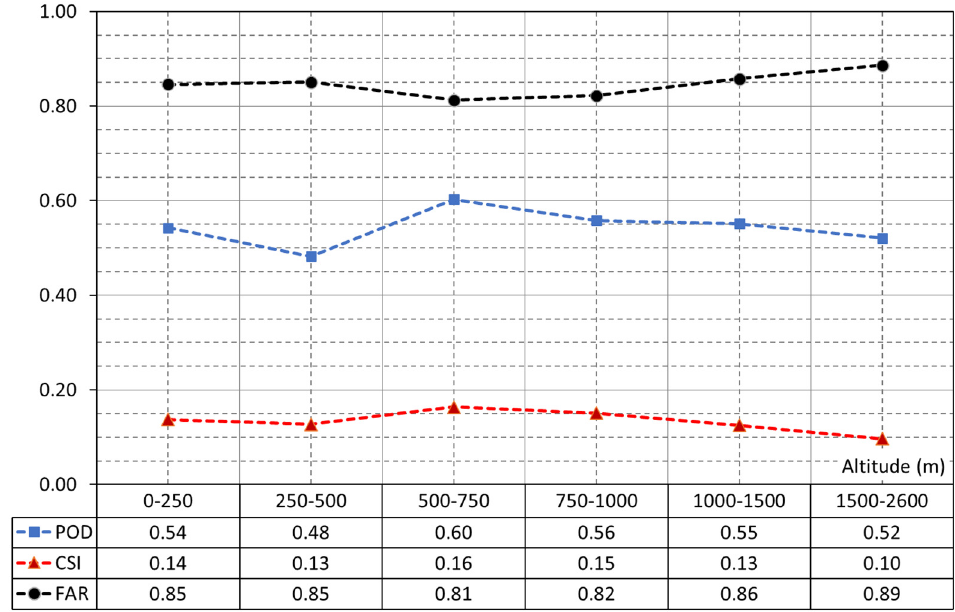
Figure 6. Variation of GPM IMERG V6 categorical metrics (POD, CSI, and FAR) with